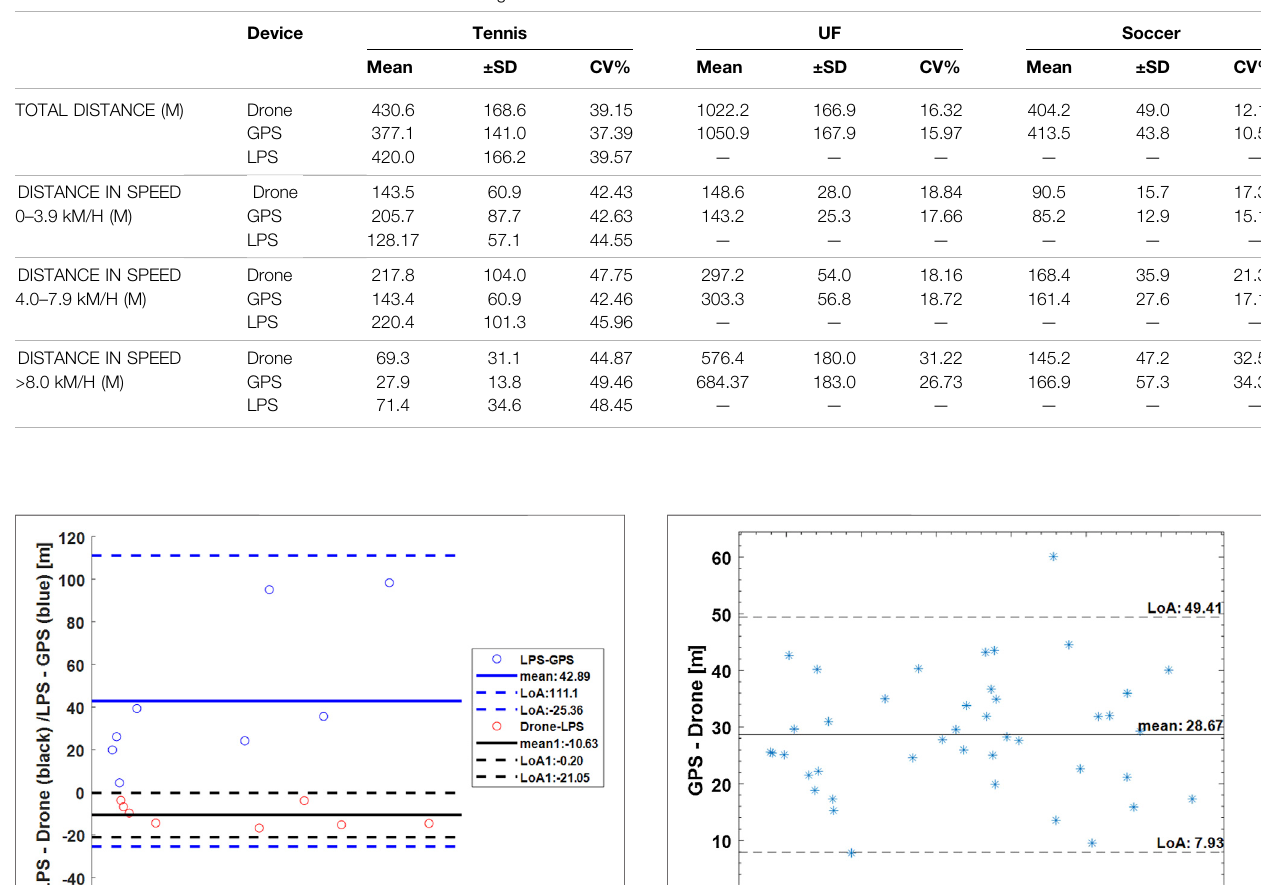
TABLE 3| Descriptivestatistics forthedifferenttracking devices(Drone/GPS/LPS)regardingtotaldistance covered andtotal distance covered inthethreedifferentspeeds: stationarywalking(0 – 3.9 km/h),jogging(4.0 – 7.9 km/h),quickrunning(above8.0 km/h)inTennis,UltimateFrisbee(UF)andSoccersmall-sidedgame.Means,standard deviations and coef fi cient of variance are shown for all the settings.